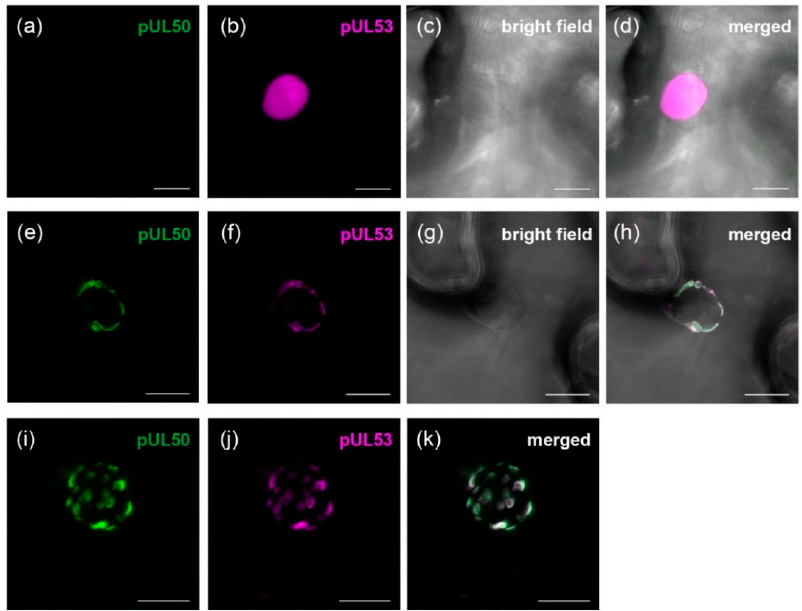
Figure 2. Expression of pUL53::tagRFP (depicted in magenta) and colocalization with eGFP::pUL50 (depicted in green). ( a )–( d ) Transient expression of pUL53::tagRFP in Nicotiana benthamiana : No fluorescence in the GFP-channel, tagRFP-signal corresponding to pUL53 was restricted to the nucleoplasm; ( e )–( h ) Coexpression of eGFP::pUL50 and pUL53::tagRFP in Nicotiana benthamiana : Colocalization of both constructs suggested that pUL50 was able to recruit pUL53 to the nuclear rim; ( i )–( k ) Coexpression of eGFP::pUL50 and pUL53::tagRFP in Nicotiana benthamiana , z-stack maximum projection: Constructs colocalized in patch-like structures at the nuclear periphery. White bars represent 10 µ